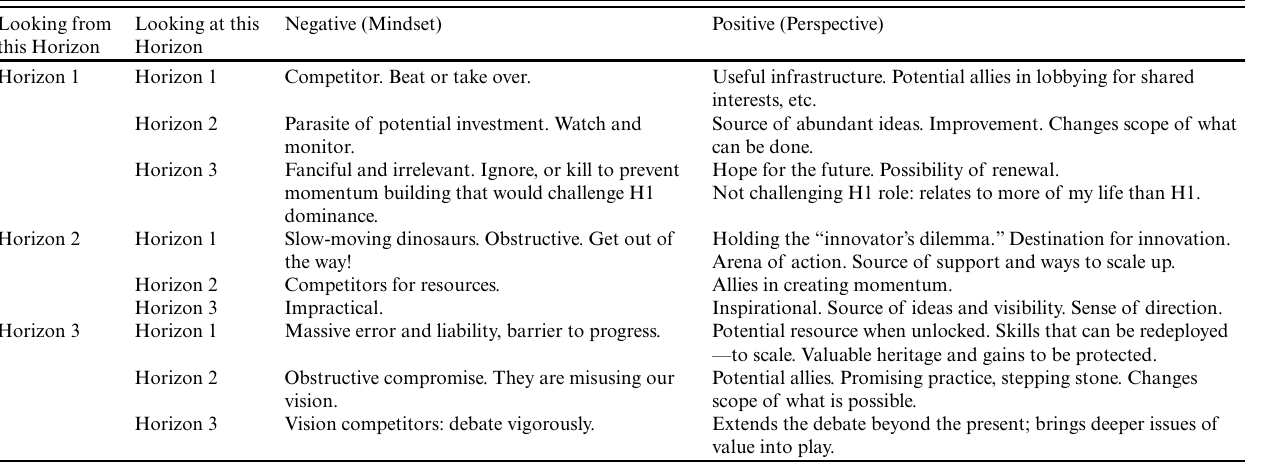
Table 2 . The different outlooks of the Three Horizons toward each other, both as a negative mindset and a positive perspective in the form of words that have been used in real sessions (based on text produced by Ian Page, personal communication ). This table is often reported to be one of the most useful things people get from using Three